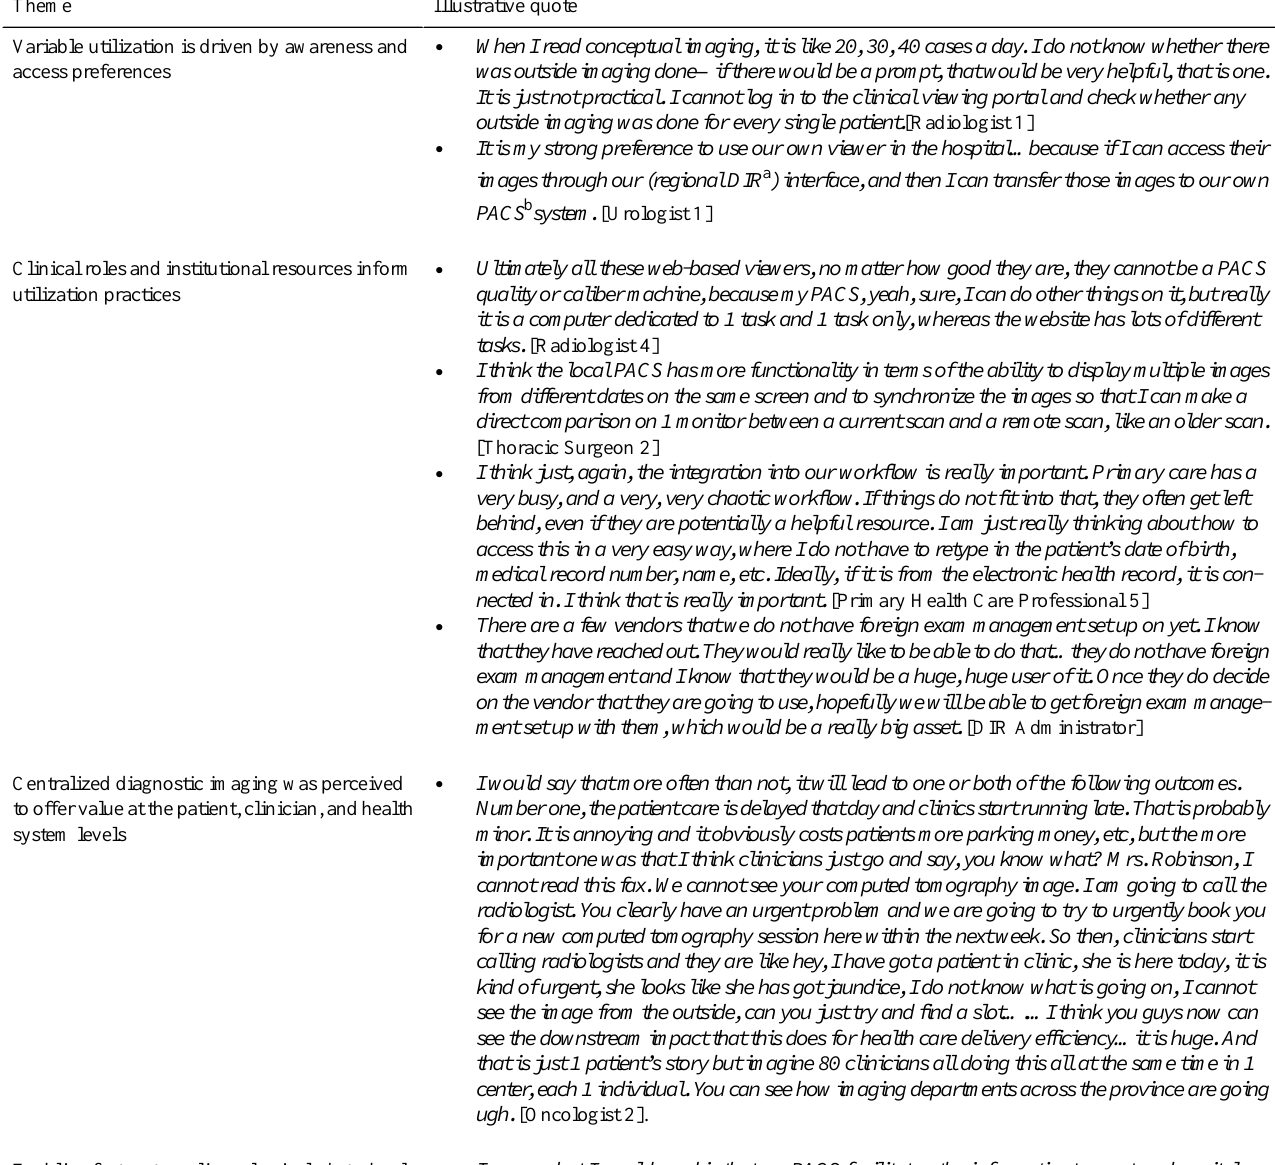
Table 2. Themes describing physician experiences and their illustrative